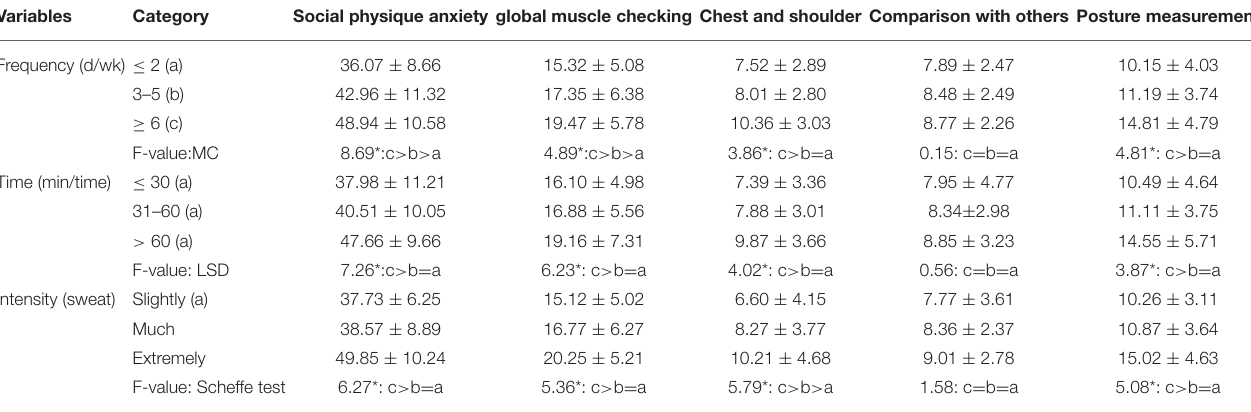
TABLE 4 | Differences in social physique anxiety scores and muscle checking sites for different weight exercise behaviors (Mean ± Standard Deviation). Variables Category